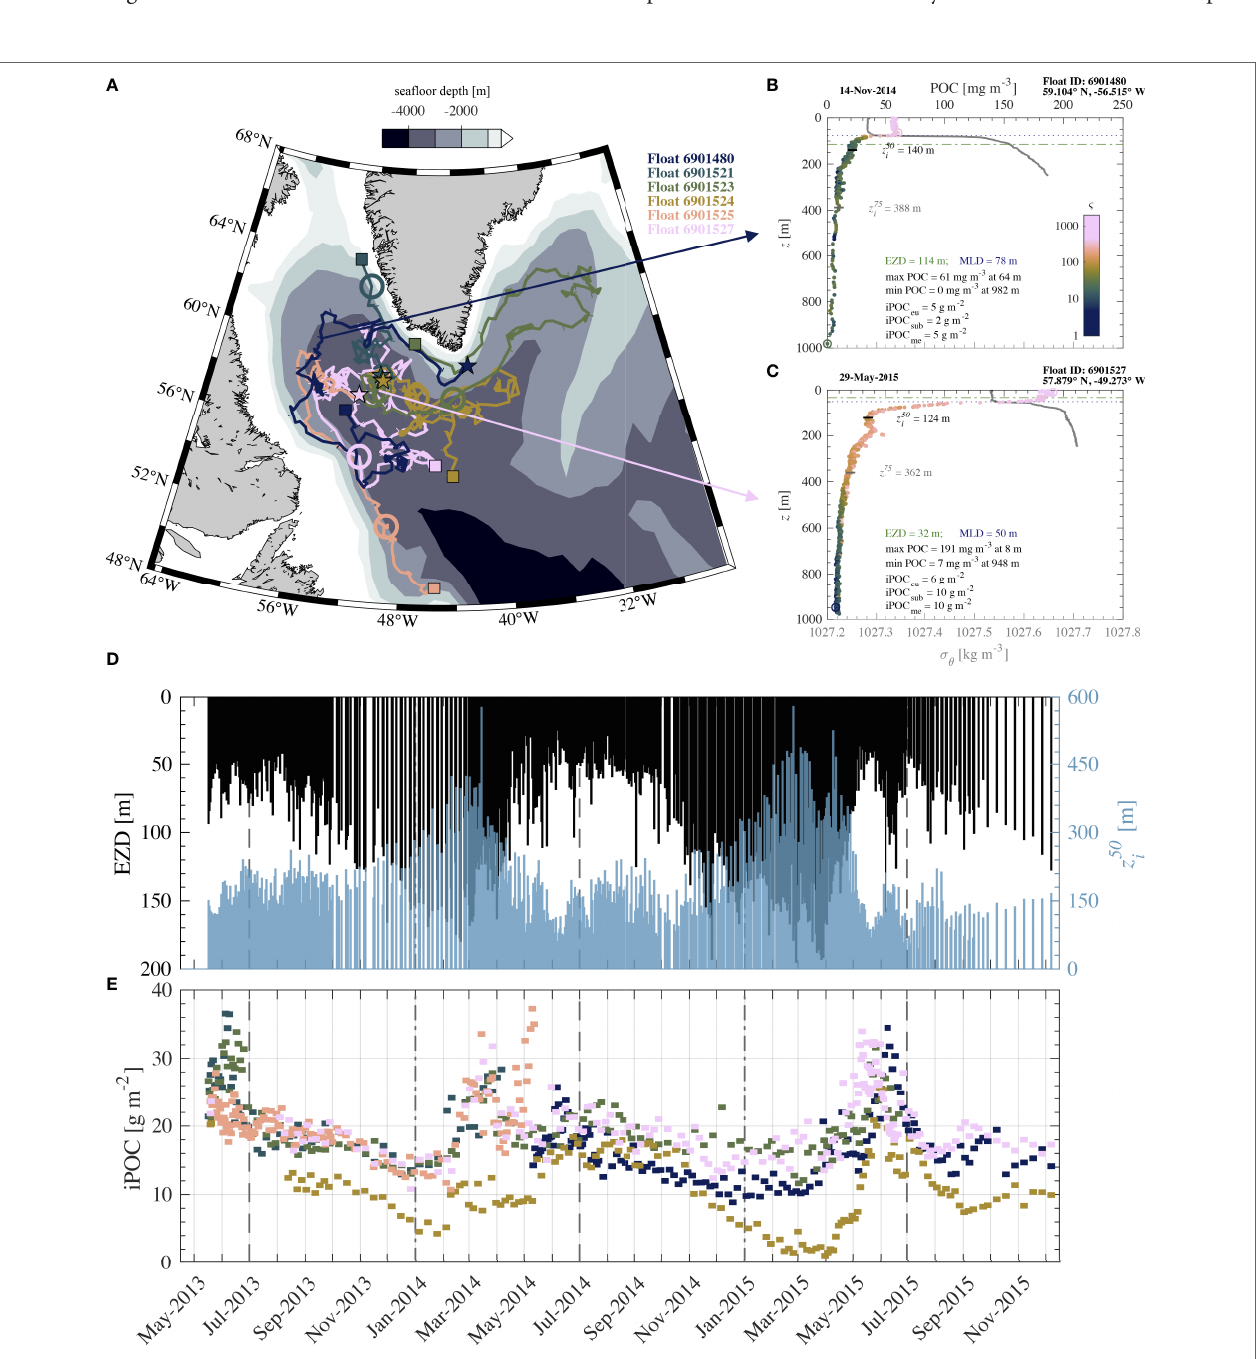
FIGURE 7 | Analysis of BGC-Argo data from six floats deployed in the Labrador Sea region and active from May 2013 through December 2015. (A) Map of region where floats were vertically profiling. Bathymetric contour lines are color-filled as indicated. Tracks are colored by float identifier with monthly tick marks. Stars indicate starting location while squares indicate ending location, and a large circle indicates approximate location of floats in March 2014. Panels (B) and (C) depict example vertical profiles of POC derived from Model B and potential density of seawater σ θ (referenced to surface pressure) for two different dates. (D) Summary of daily averages of the euphotic zone depth (EZD) in black and z i50 (with an inverted y-axis) in blue derived from BGC-Argo data (see text for details). (E) Total integrated POC within top 1 km of water column (i.e., iPOC eu + iPOC sub + iPOC me ) derived from each BGC-Argo float as indicated by color in (A)